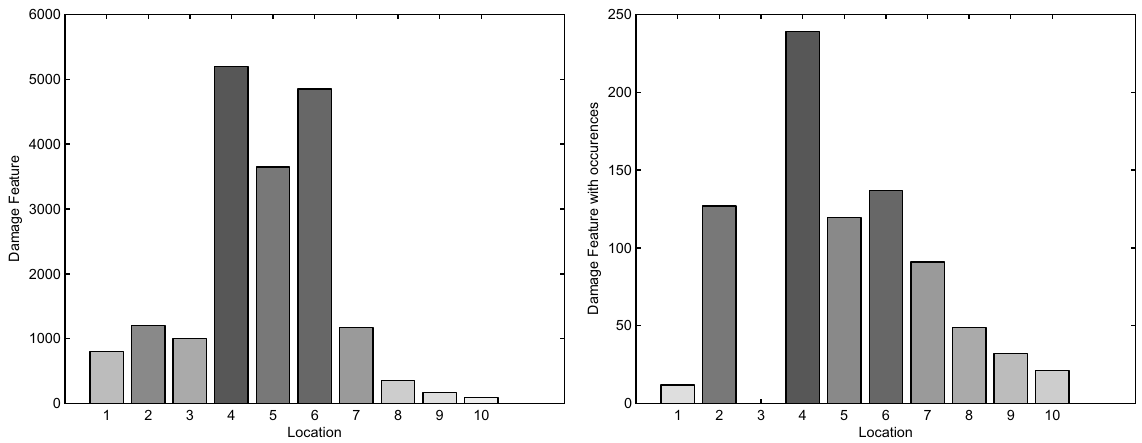
Fig. 32. Damage feature without and with occurrences for damaged structure and changing loading conditions, frequency range 10–100 Hz.